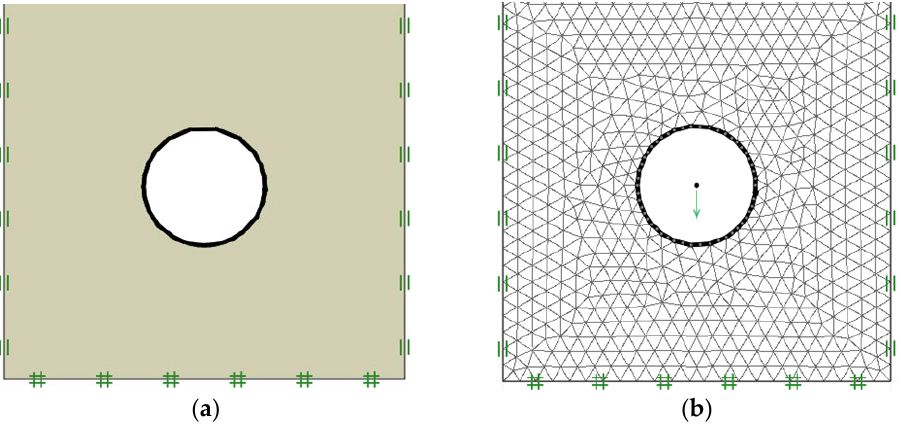
Figure 7. ( a ) Numerical model and ( b ) meshed numerical model.